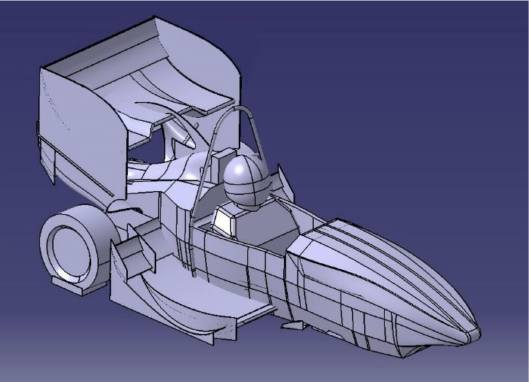
Figure 6. Simulation model after canceling the front wheel and front wing.